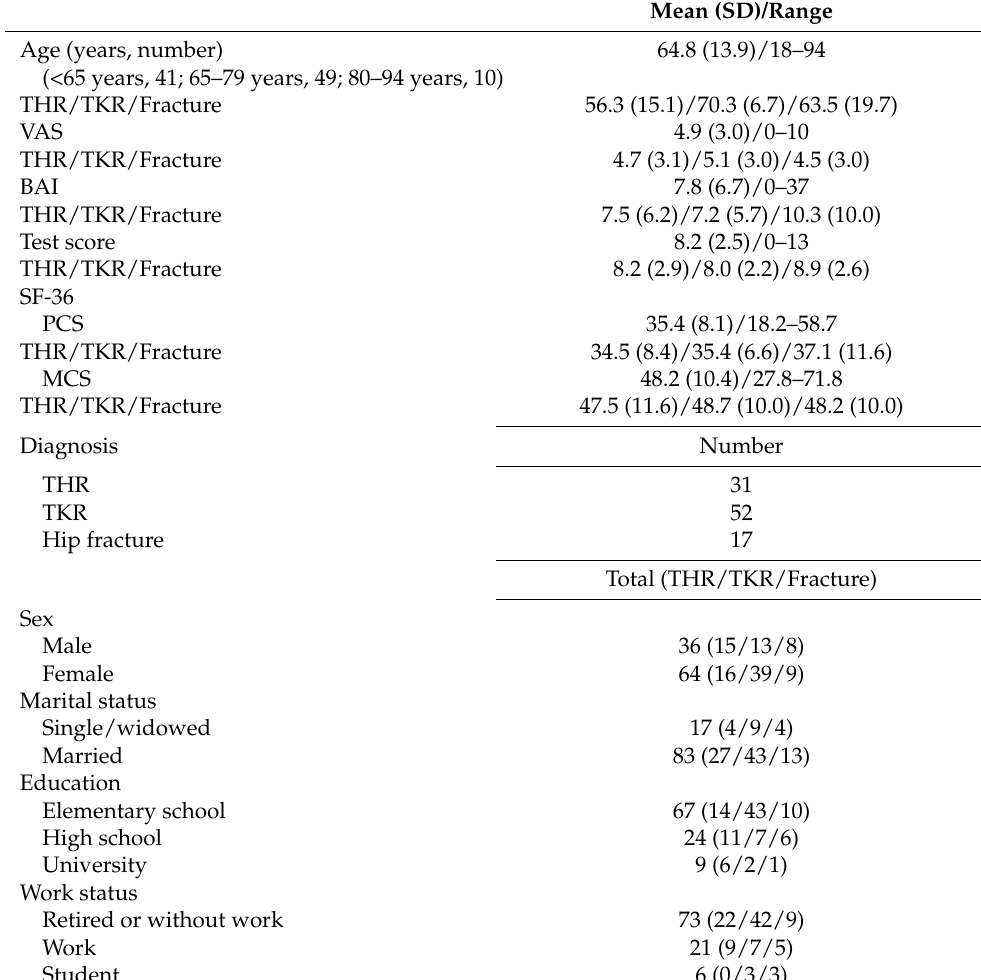
Table 1. Demographic data and clinical characteristics of patients before